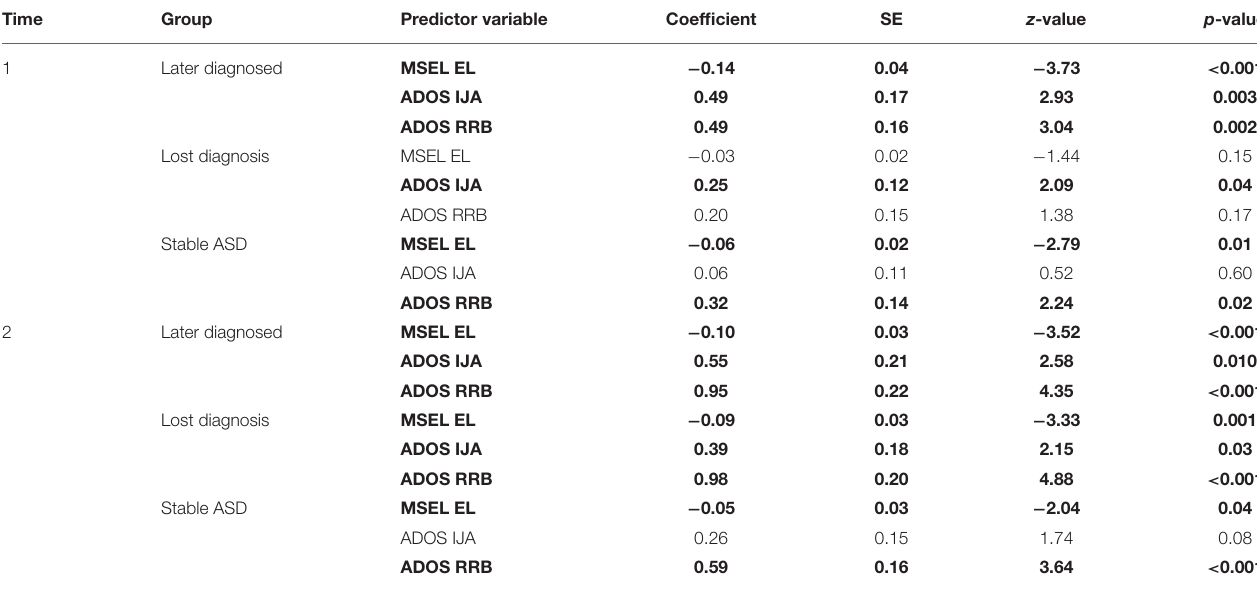
TABLE 6 | Parameter estimates of the variables in the multinomial logistic regression model, in which the variables with p -values indicated in bold text, significantly predict the likelihood of belonging to the indicated 5.7 year outcome group. Time Group Predictor variable Coefficient SE z -value p -value Later